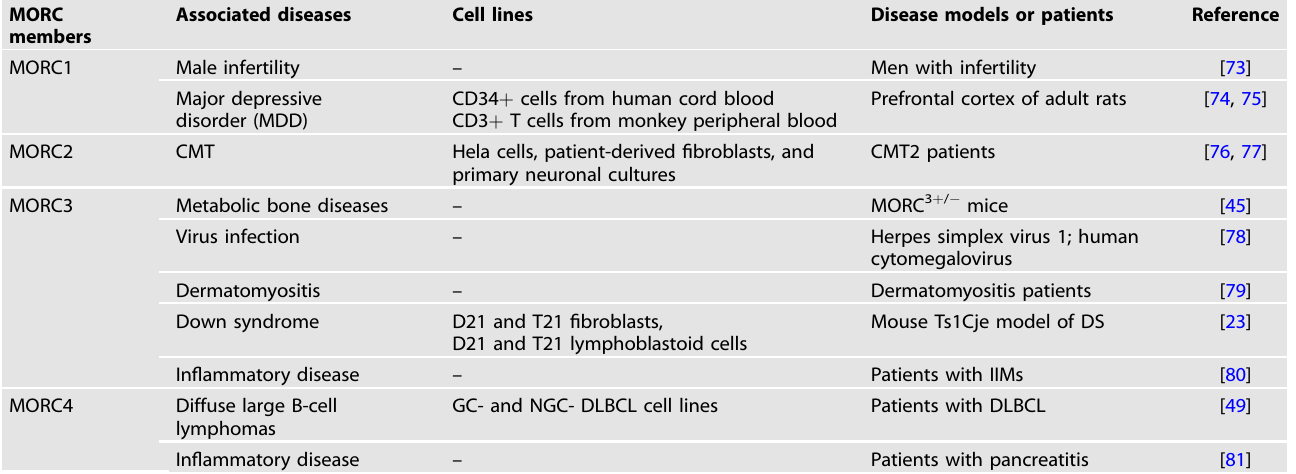
Table 4. MORC family associated